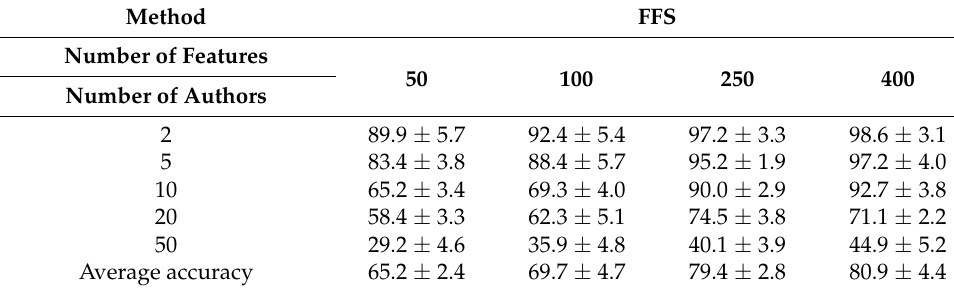
Table 6. Feature selection methods (SFS).